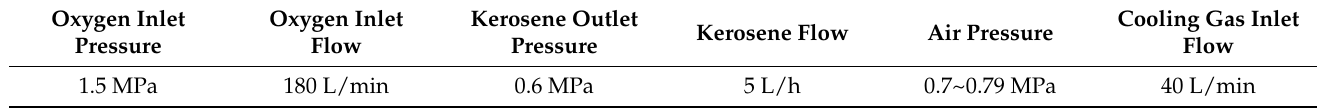
Figure 3. Single thermal shock cycle used for the TBCs. Table 5. Experimental parameters of environmental simulator test